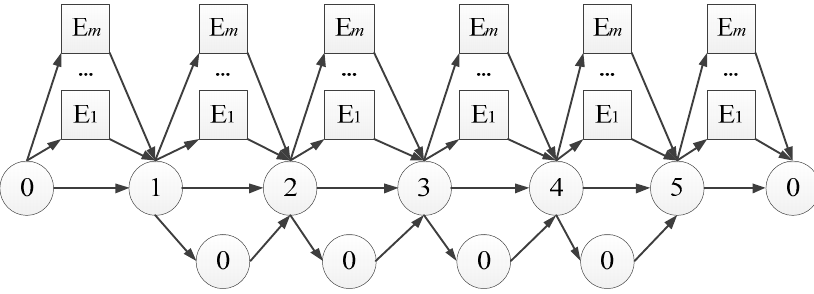
Figure 2. Auxiliary graph in the labeling algorithm.